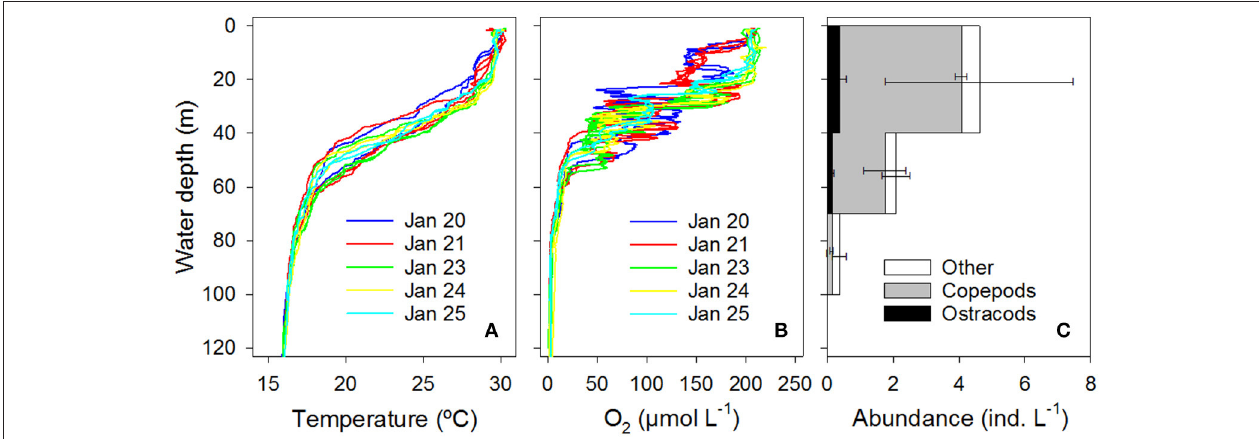
FIGURE 2 | Environmental settings in Golfo Dulce. Vertical gradients of (A) temperature and (B) O 2 concentration obtained from multiple CTD casts during the time of the current study; profiles shown in the same color were measured on the same day. (C) Vertical distribution of copepods, ostracods, and other